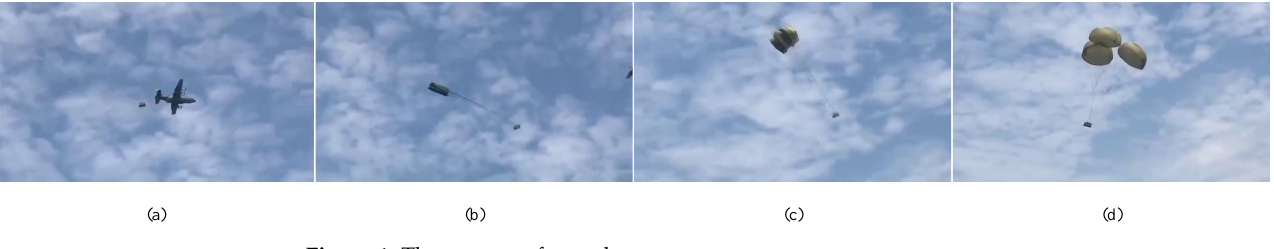
Figure 1. The process of parachute